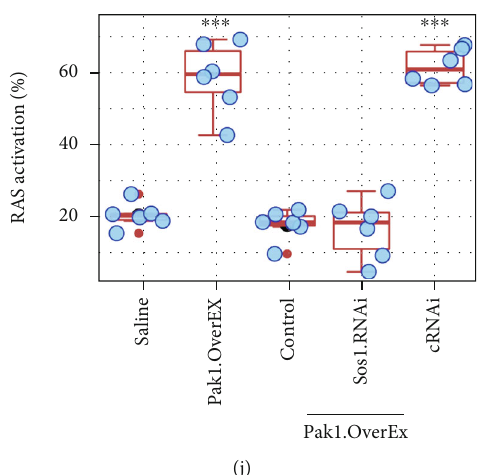
Figure 3: Assessment of the role of Pak1 in RAS activation in sensitized mast cells. (a – c) Sensitized (Sens) and naïve control (Con) BMMCs were analyzed by RAS-speci fi c ELISA. Violin plots show RAS.GTP levels (a), RAS.GDP levels (b), and RAS activation status (c). (d) Positive correlation between RAS activation and Pak1 mRNA levels in sensitized BMMCs. (e, f) Pak1 mRNA (e) and protein (f) levels in sensitized BMMCs. FTS: a pan inhibitor of RAS in the culture (75 μ M). (g) A triple complex of Pak1, Sos1, and kRAS in sensitized BMMCs. (h – j) RAS activation in BMMCs after the treatment denoted on the x axis. Pak1.OverEx: BMMCs with Pak1 overexpression. Control: BMMCs were transfected with empty plasmids. Sos1.RNAi (cRNAi): BMMCs were treated with Sos1 RNAi (or control RNAi). The data in the violin plots and boxplots are presented as median (IQR). Each bubble presents data obtained from one experiment. ∗∗∗ p < 0 : 00 1 [Student t